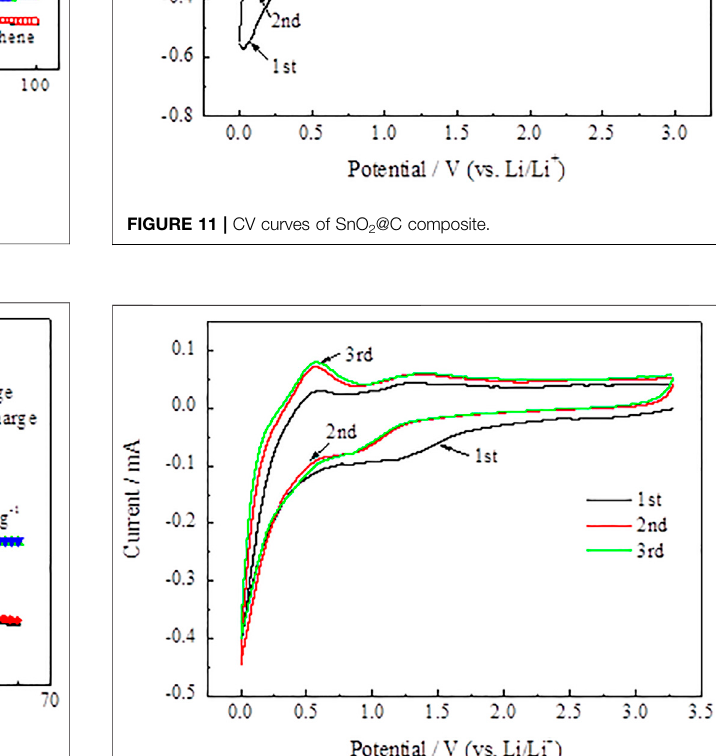
FIGURE 12 | CV curves of SnO 2